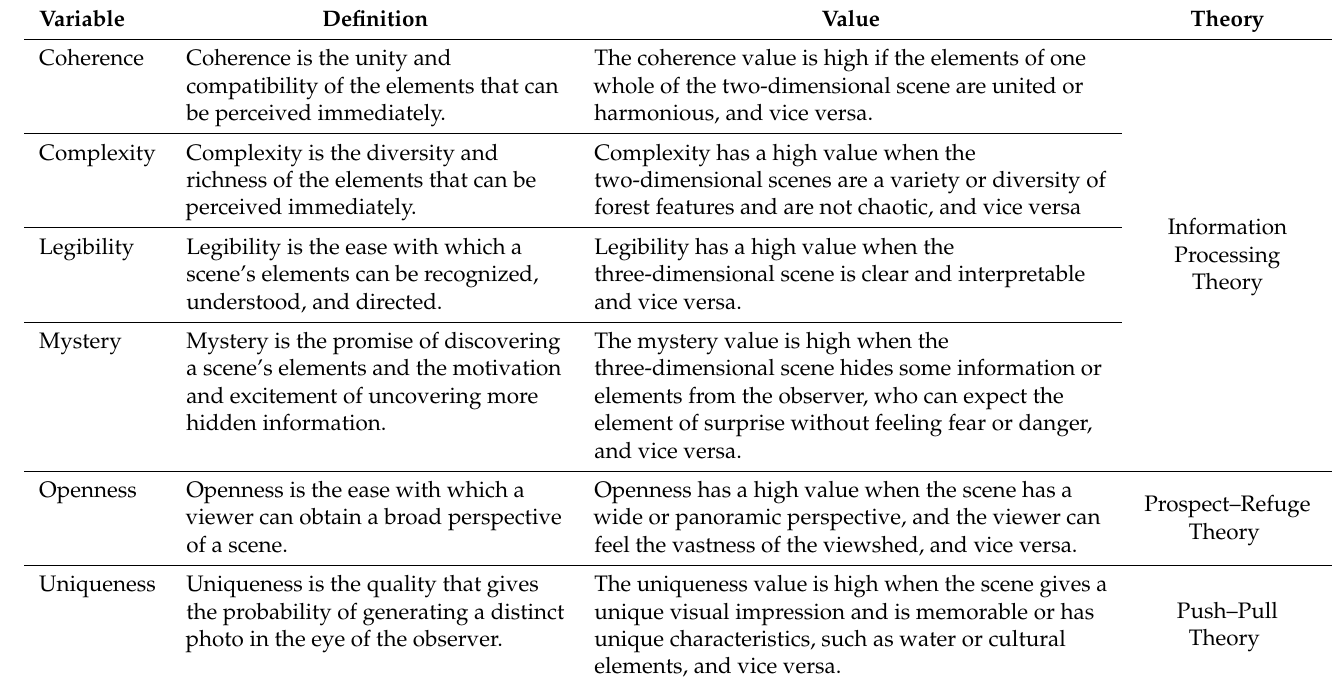
Table 1. Definition and value of the variables used in this research. Source: Mundher